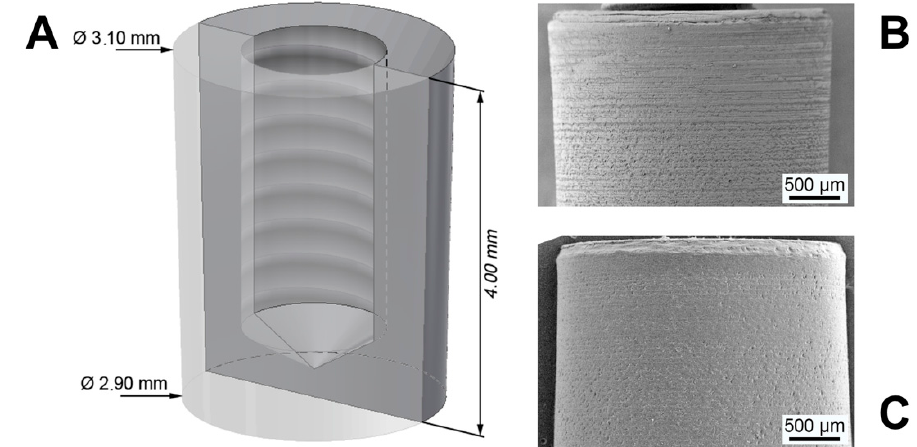
Figure 1. ( A ) Dimensions of PEEK implants. ( B ) SEM images of SiO 2 /HA-coated PEEK implant. ( C ) SEM images of pure PEEK implant.